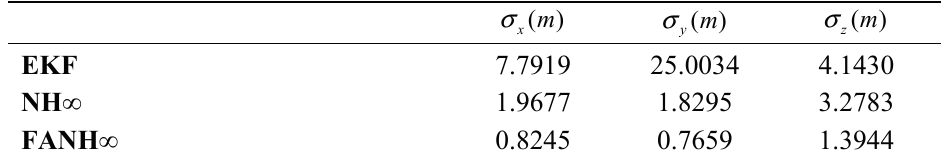
Table 1. Comparison of the standard deviation between the EKF, NH ∞ and FANH ∞